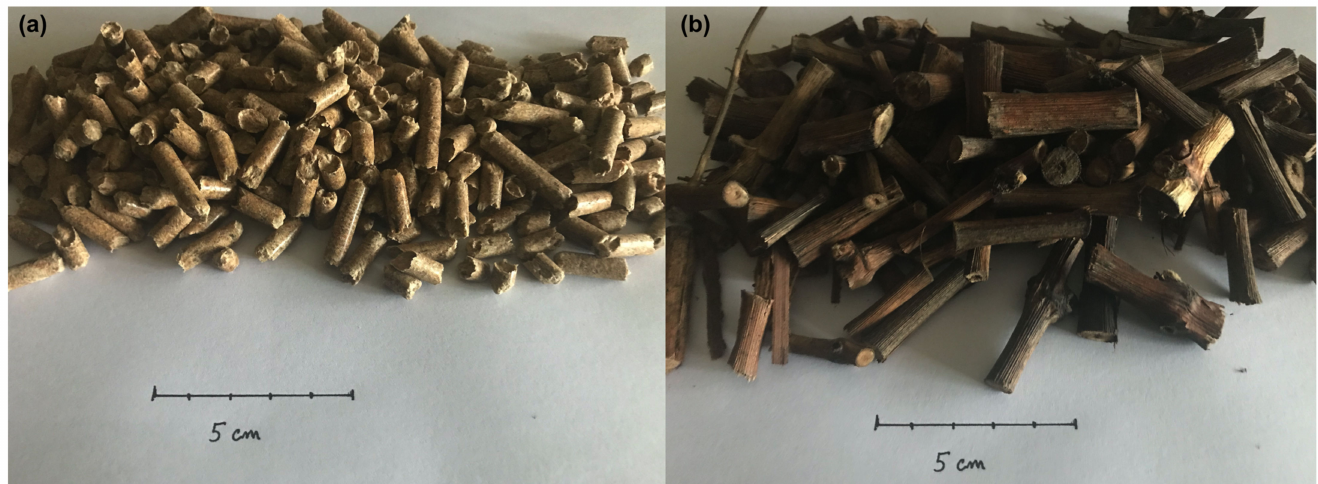
Figure 1. Samples collected for the characterization tests. ( a ) Pellets with ENplus ® A1 certification; ( b ) vine pruning already cut to a size close to that of the